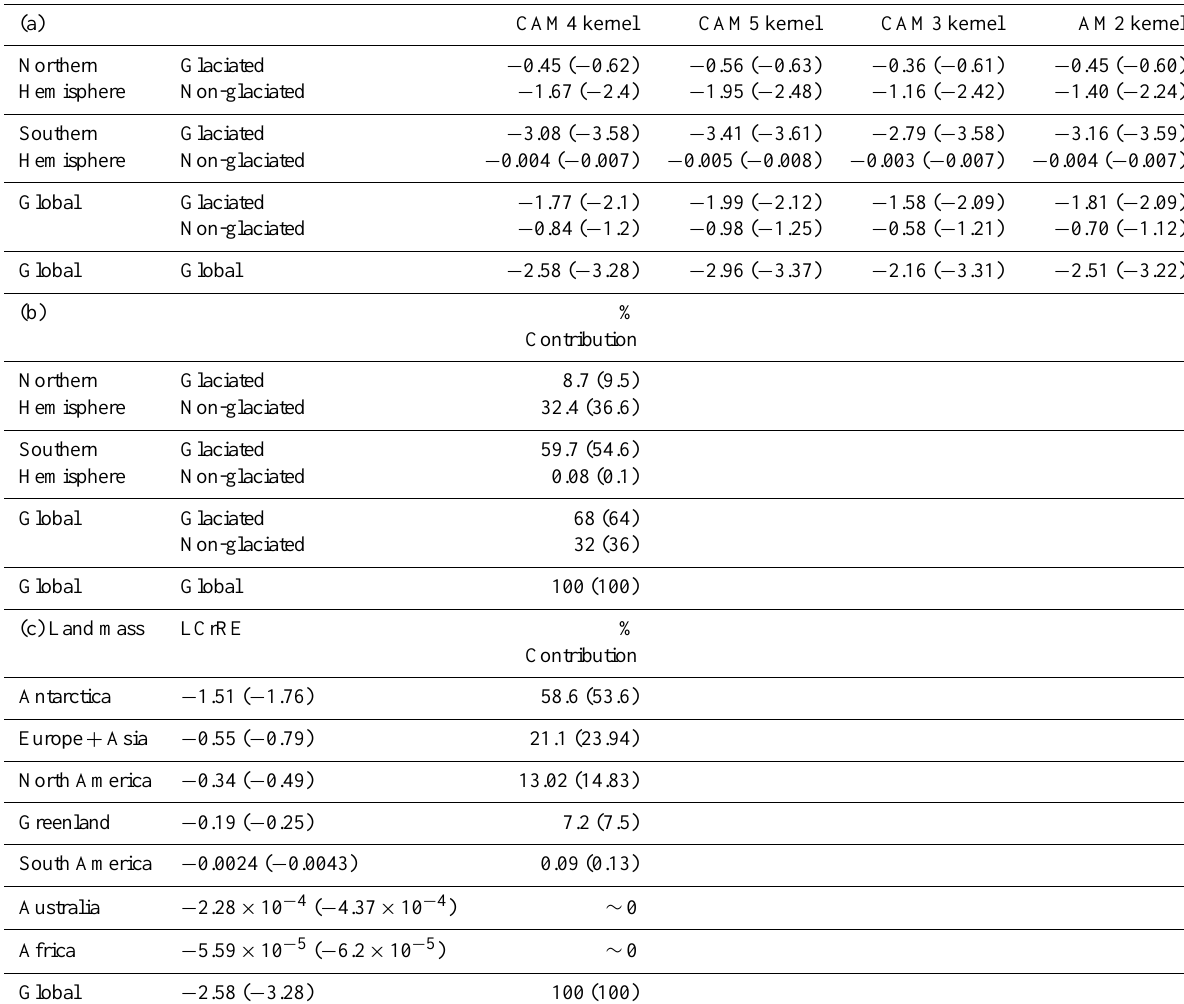
Table 1. (a) All-sky (clear-sky) cryosphere radiative effect averaged over different domains and derived with various radiative kernels (Wm − 2 ). (b) Percentage contribution of different domains to the global LCrRE using CAM4 kernels. (c) Percentage contribution of different land masses to the global LCrRE using CAM4